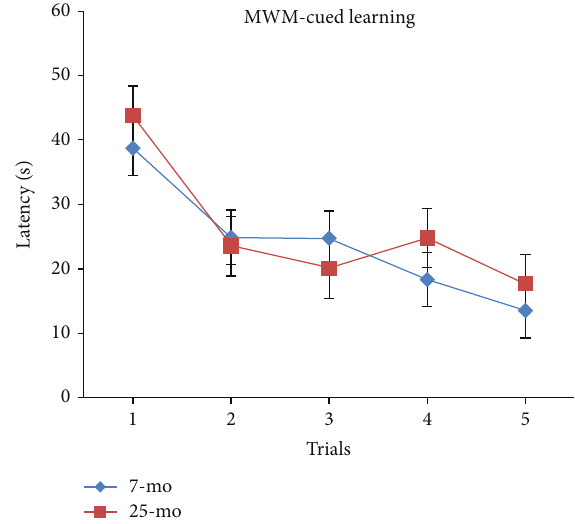
Figure 2: Latencies of 7- and 25-month-old C57BL/6 mice in cued learning of MWM (s, mean ±